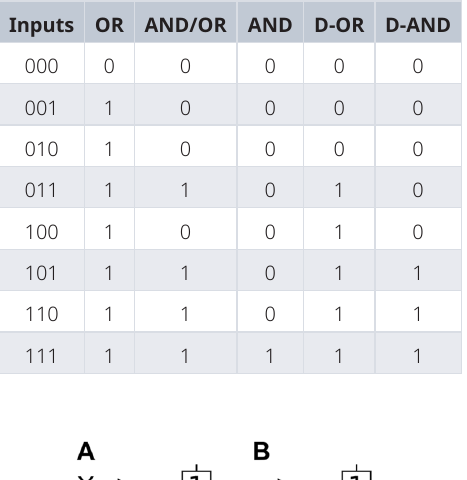
Table 2. The five classes of positive threshold functions for n = 3 inputs with their associated truth tables. We have assigned a name to each class for easier reference. Inputs OR AND/OR AND D-OR D-AND